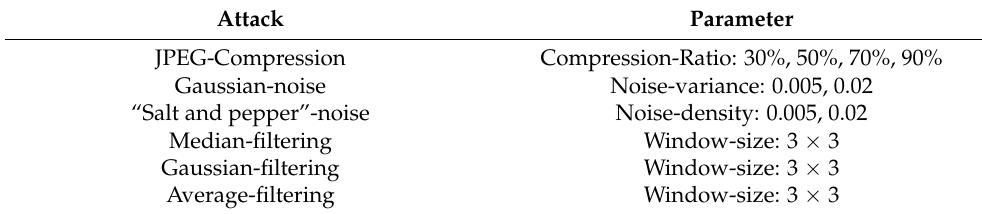
Table 2. The extracted watermarks and the corresponding BER and NC values under common im- age processing attacks.